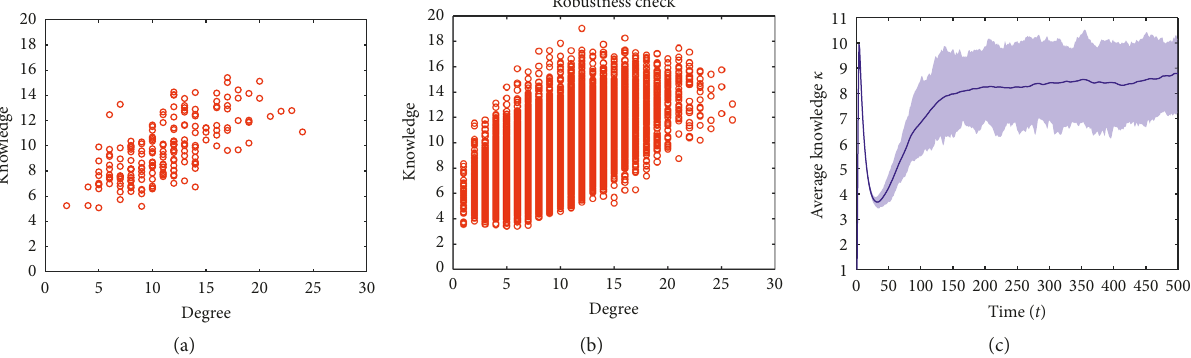
Figure 5: Evolution result when the initial R&D network structure is a WS small-world network ( p � 0 . 2).